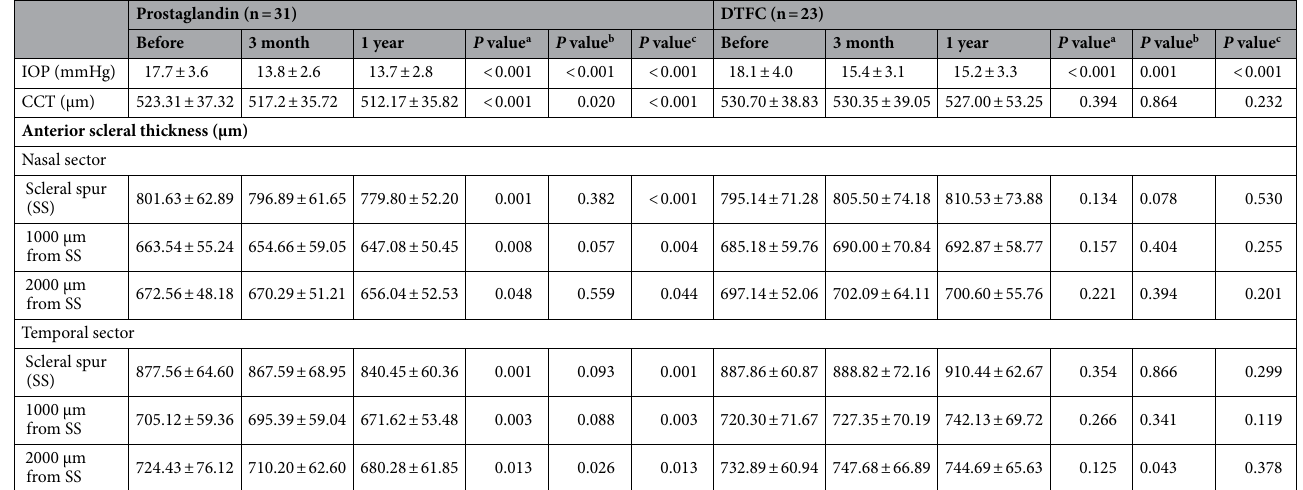
Table 3. Comparison of the anterior scleral thickness before and after using topical medications. DTFC dorzolamide/timolol fixed combination, IOP intraocular pressure, CCT central corneal thickness. a Repeated measures ANOVA. b Paired t-test (pairwise comparison between baseline and 3 month values, P < 0.025 is considered statistically significant). c Paired t-test (pairwise comparison between baseline and 1 year values, P < 0.025 is considered statistically